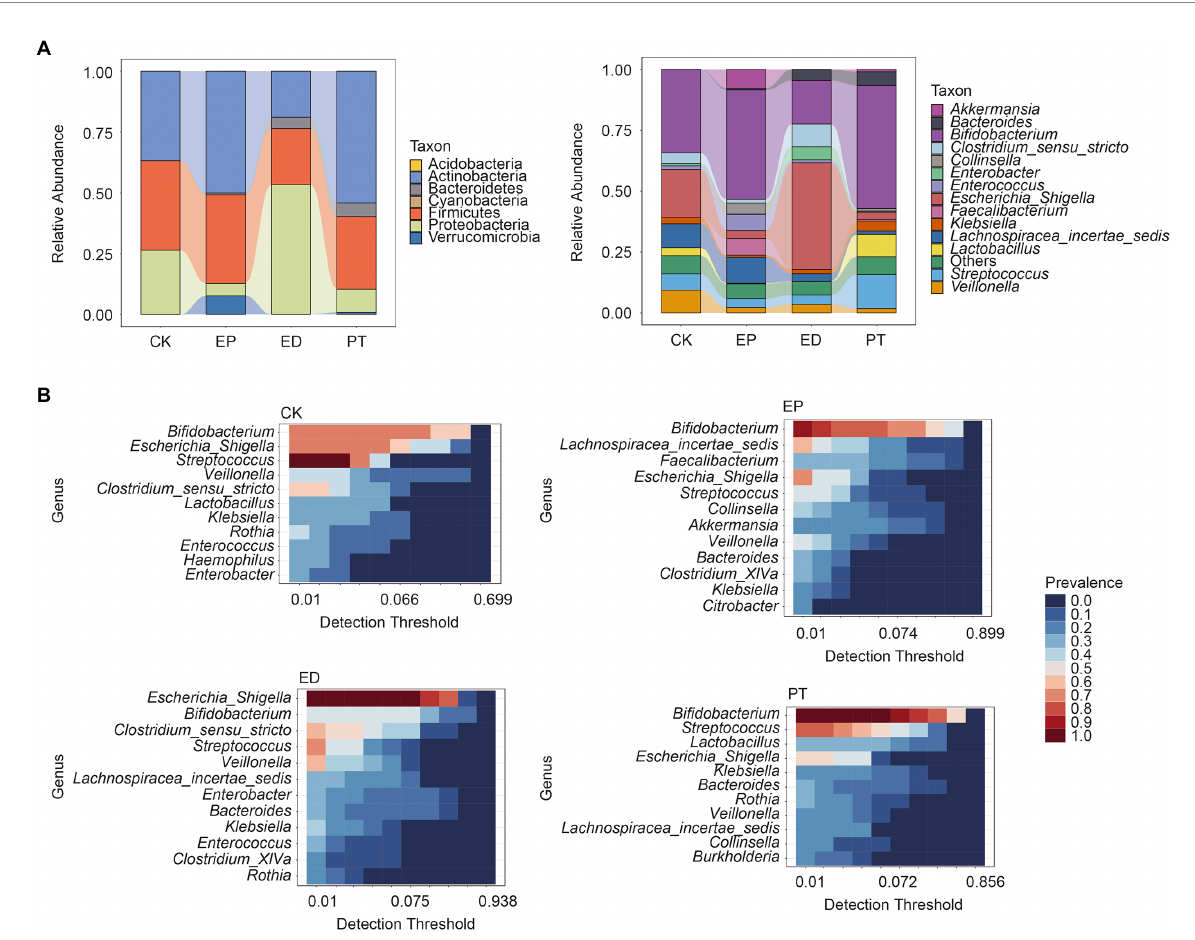
FIGURE 3 Relative abundance and core microbiota among individuals within different groups. (A) The relative abundance at the phylum and genus levels in different groups. (B) The core microbiota at the genus level in different groups. Detection threshold represents the relative